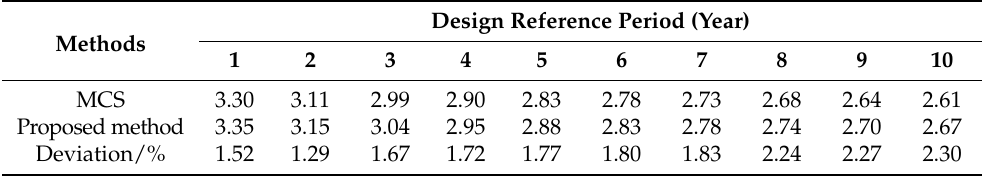
Table 8. Reliability index of the roof truss structure in each design reference